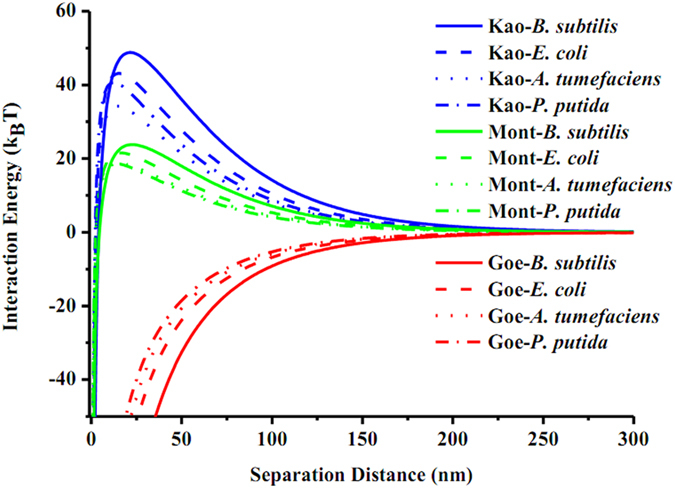
Total interaction energy profiles as a function of separation distance between bacteria and minerals in deionized water.